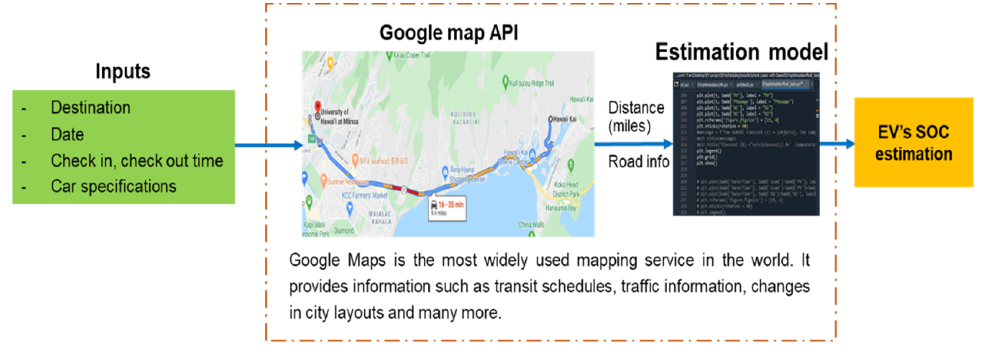
Figure 3. Three ‐ step EV’s SOC estimation for a pre ‐ identified trip process. Figure 3. Three-step EV’s SOC estimation for a pre-identified trip